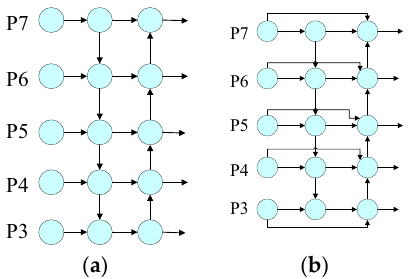
Figure 8. Network structures of PANet and P2P-PANet. ( a ) PANet network structure. ( b ) P2P-PANet network structure.